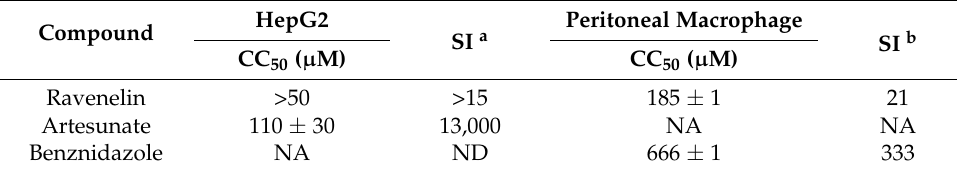
Table 3. Cytotoxicity in HepG2 cell and BALB/c peritoneal macrophages, and selectivity index of ravenelin. Compound